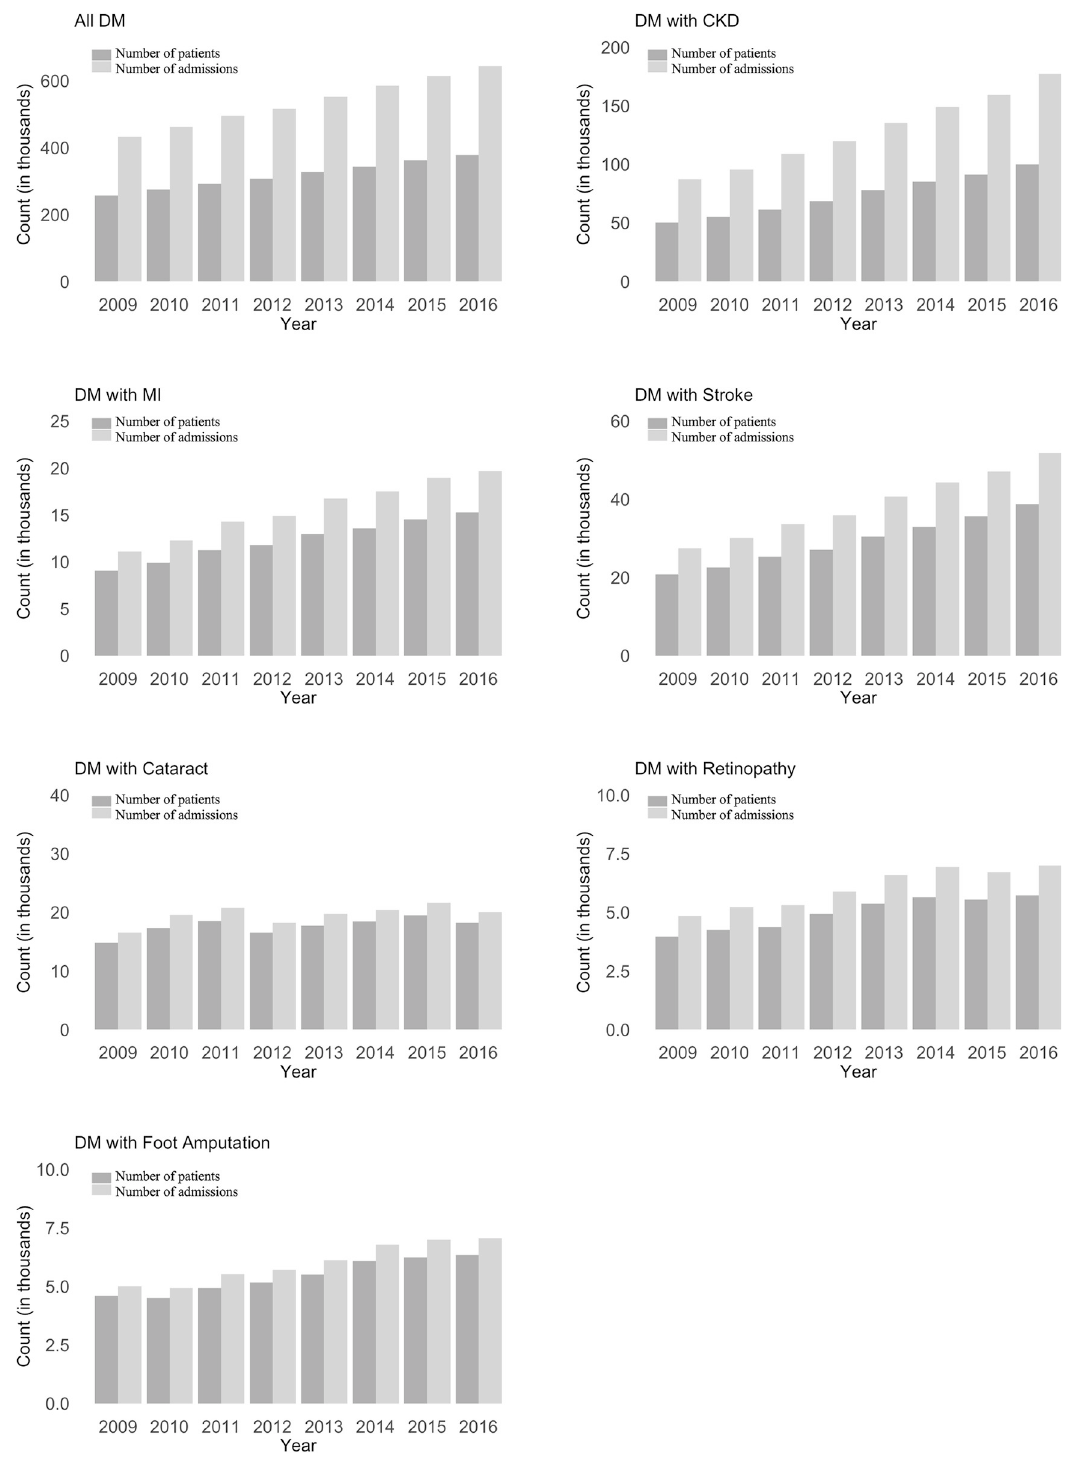
Fig 3. The number of patients and the number of admissions of type 2 diabetes mellitus with the six major complications under the Universal Coverage Scheme in Thailand from 2009 to 2016. Note: The number of admissions refers to how many times the Universal Coverage Scheme (UCS) patients were admitted for type-2 diabetes mellitus (T2DM) with complications in each year, whereas the number of patients refers to how many T2DM patients were admitted in the year. A patient could be admitted for multiple times in a year. The scale for Y-axis varies between